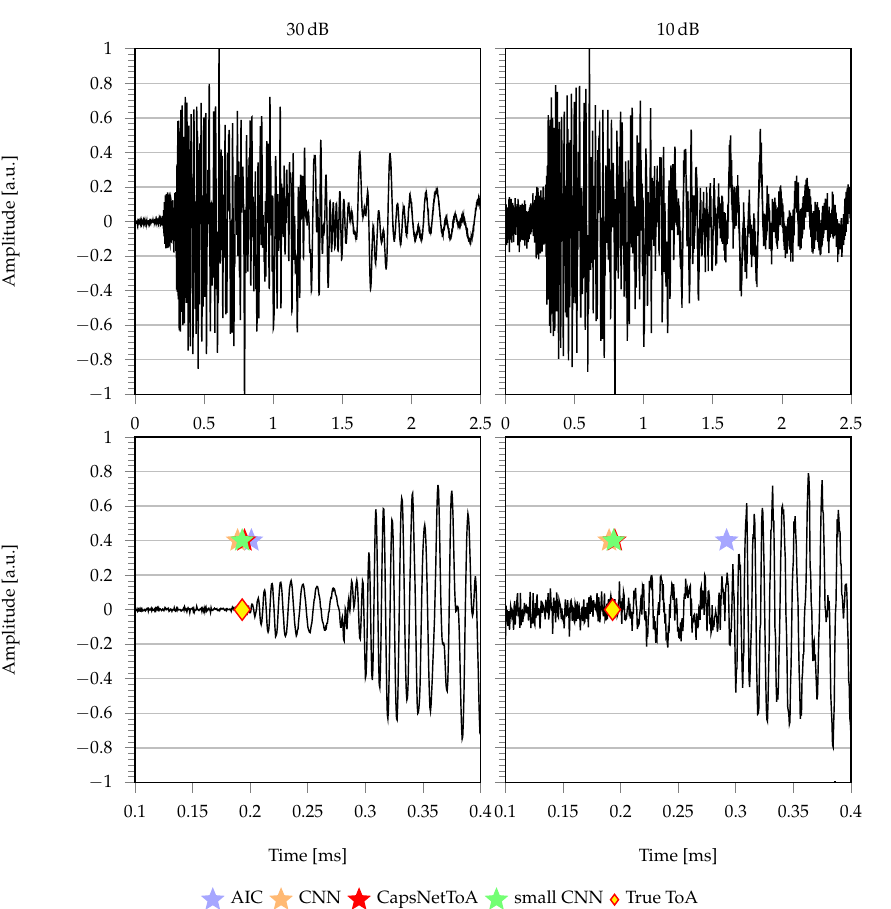
Figure 7. ToA predictions for AIC (blue), CNN (orange), CapsNetToA (red) and small CNN (green) with synthetic dataset: ( left column ) SNR = 30dB and ( right column ) SNR = 10dB, with second row depicting a magnified region of the time interval where ToA is